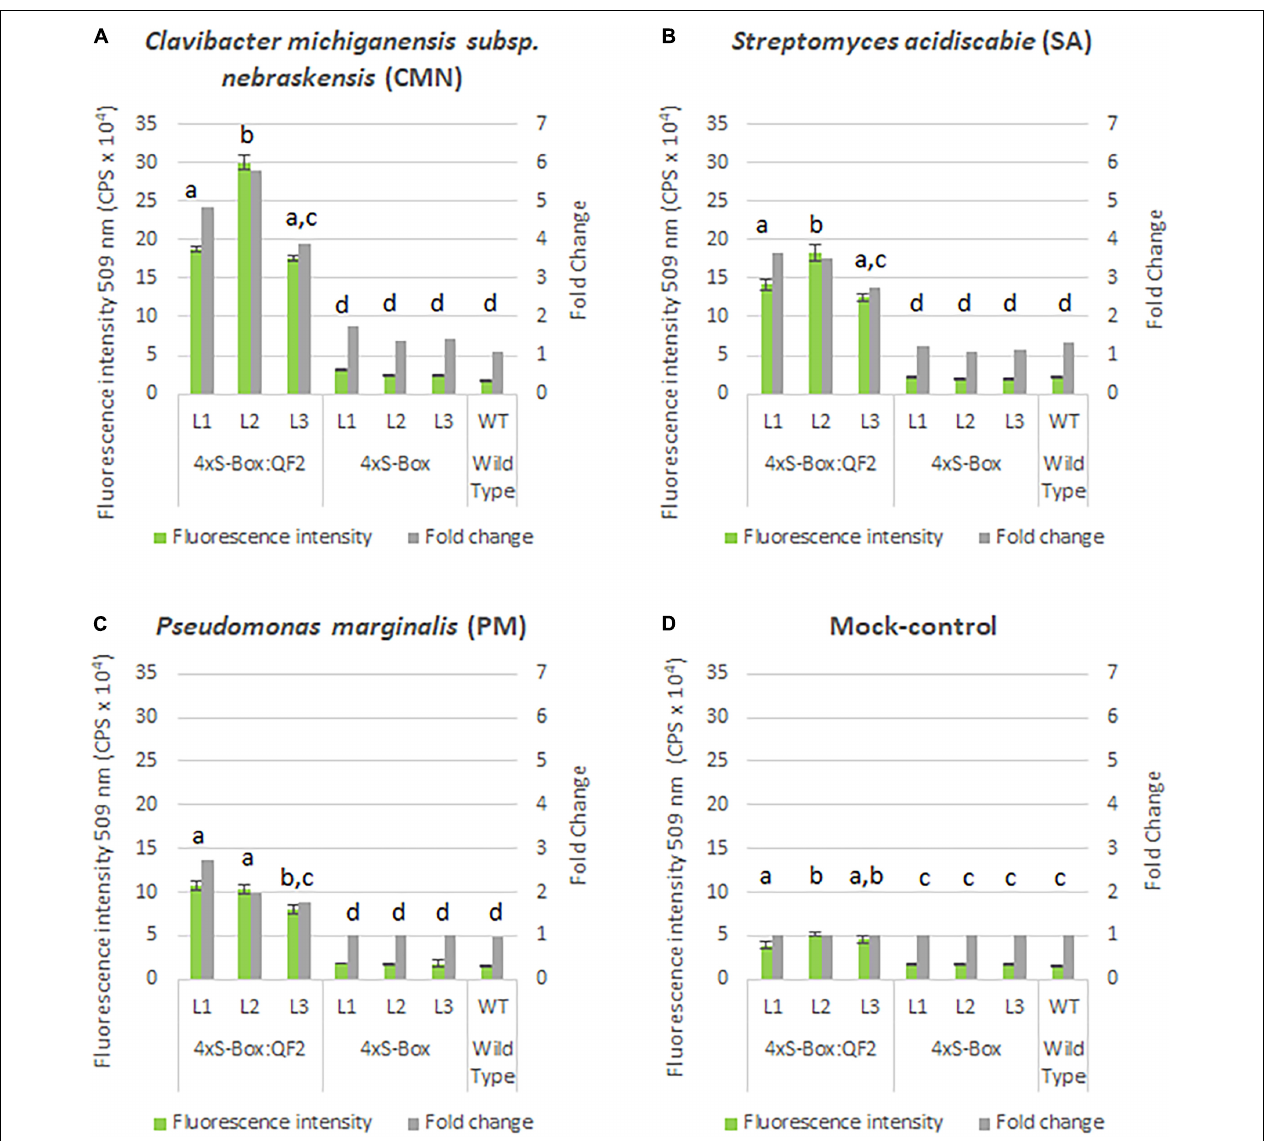
FIGURE 4 | Spectral analysis of mEmerald emission in pathogen phytosensors. Spectral data represent mEmerald peak emission for transgenic phytosensor 4xS-Box:QF2 (with Q-system) and 4xS-Box (without Q-system), and WT (wild type) plants at 72 h post inoculation with bacterial pathogens: (A) Clavibacter michiganensis subsp. nebraskensis (CMN), (B) Streptomyces acidiscabie (SA), (C) Pseudomonas marginalis (PM), and (D) 10 mM MgCl 2 (mock-control). Plants were infiltrated with a bacterial inoculum of OD 600 = 0.3, corresponding to colony forming units (cfu) of 3 × 10 8 cfu/ml CMN, 3 × 10 8 cfu/ml SA, and 1 × 10 8 cfu/ml PM. Spectral data measured at 509 nm emission obtained with a 475 nm excitation wavelength. Statistically significant differences determined using ANOVA, Tukey HSD post hoc analysis: groups with different letters show a significant difference ( p < 0.05). Three independent experiments with four biological replicate